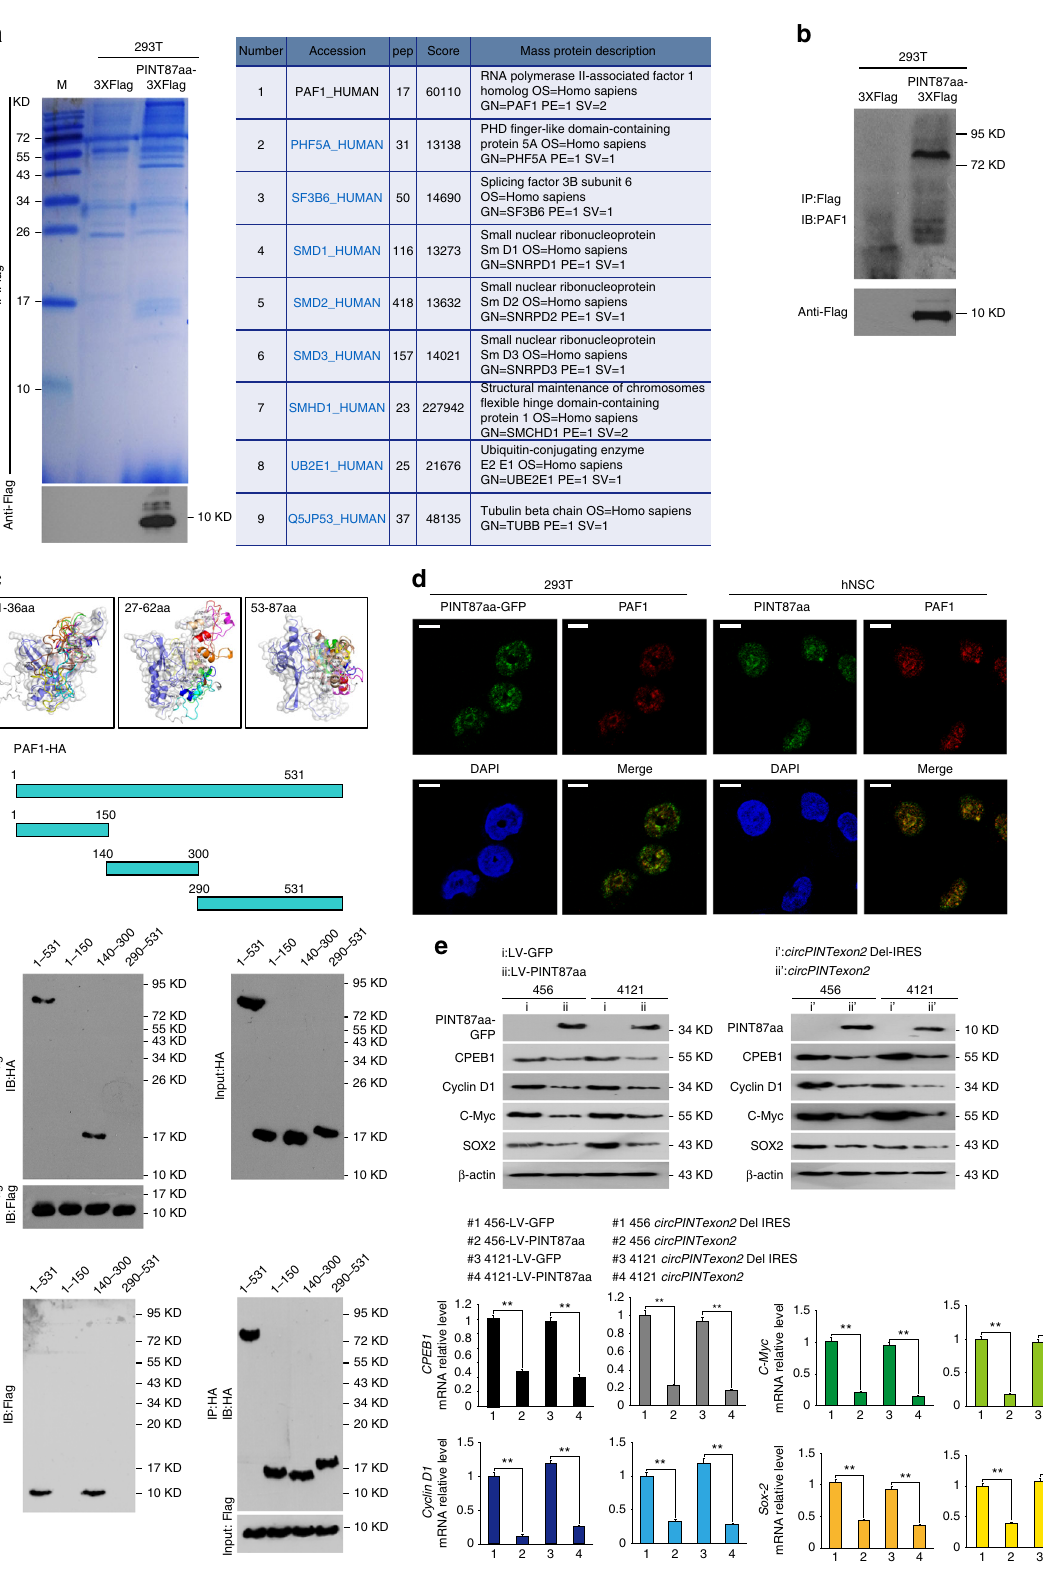
53 – 87 aa. The top ten peptides in complex with PAF1 were visualized with different colors by PyMOL (The PyMOL Mole- cular Graphics System, Version 1.8 Schrödinger, LLC.), while protein – peptide interface residues (within 5 Å for each